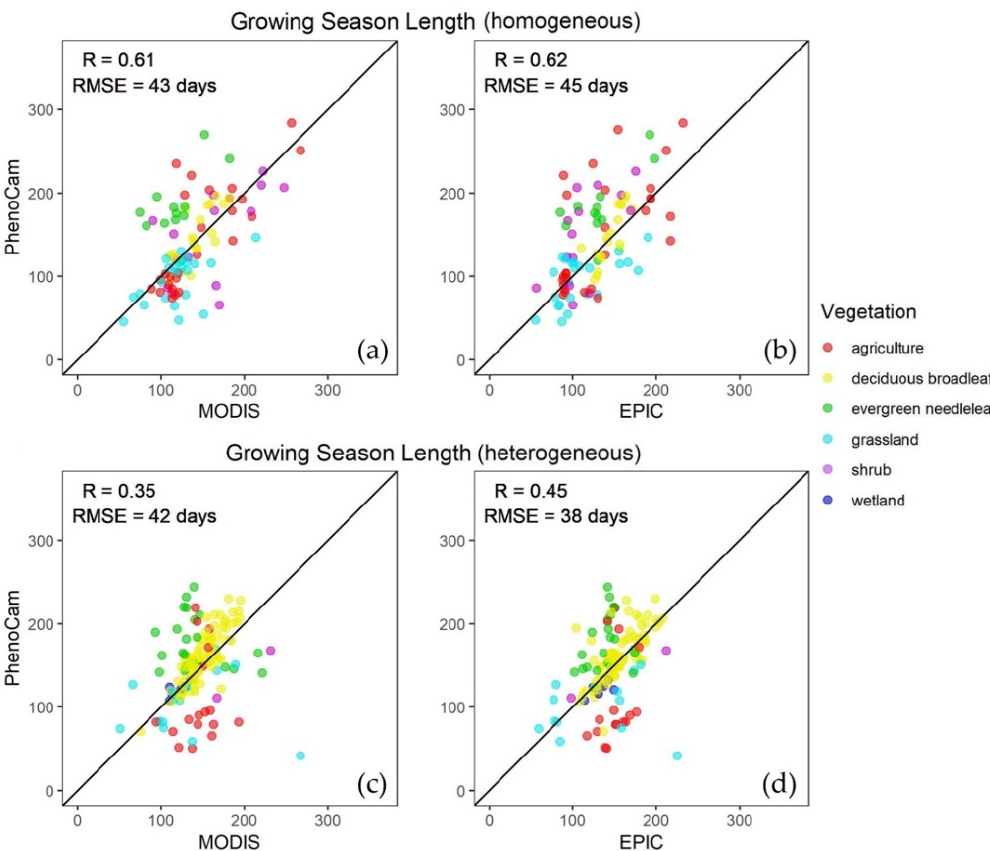
Figure 14. The correlation of GSL (in days) for PhenoCam and ( a ) MODIS and ( b ) EPIC for homogeneous sites only, and PhenoCam and ( c ) MODIS and ( d ) EPIC for heterogeneous sites only during 2016–2018.